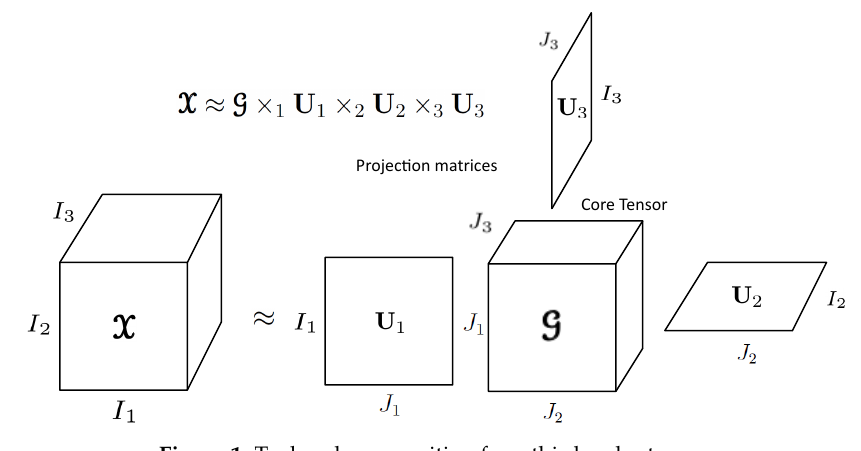
Figure 1. Tucker decomposition for a third-order